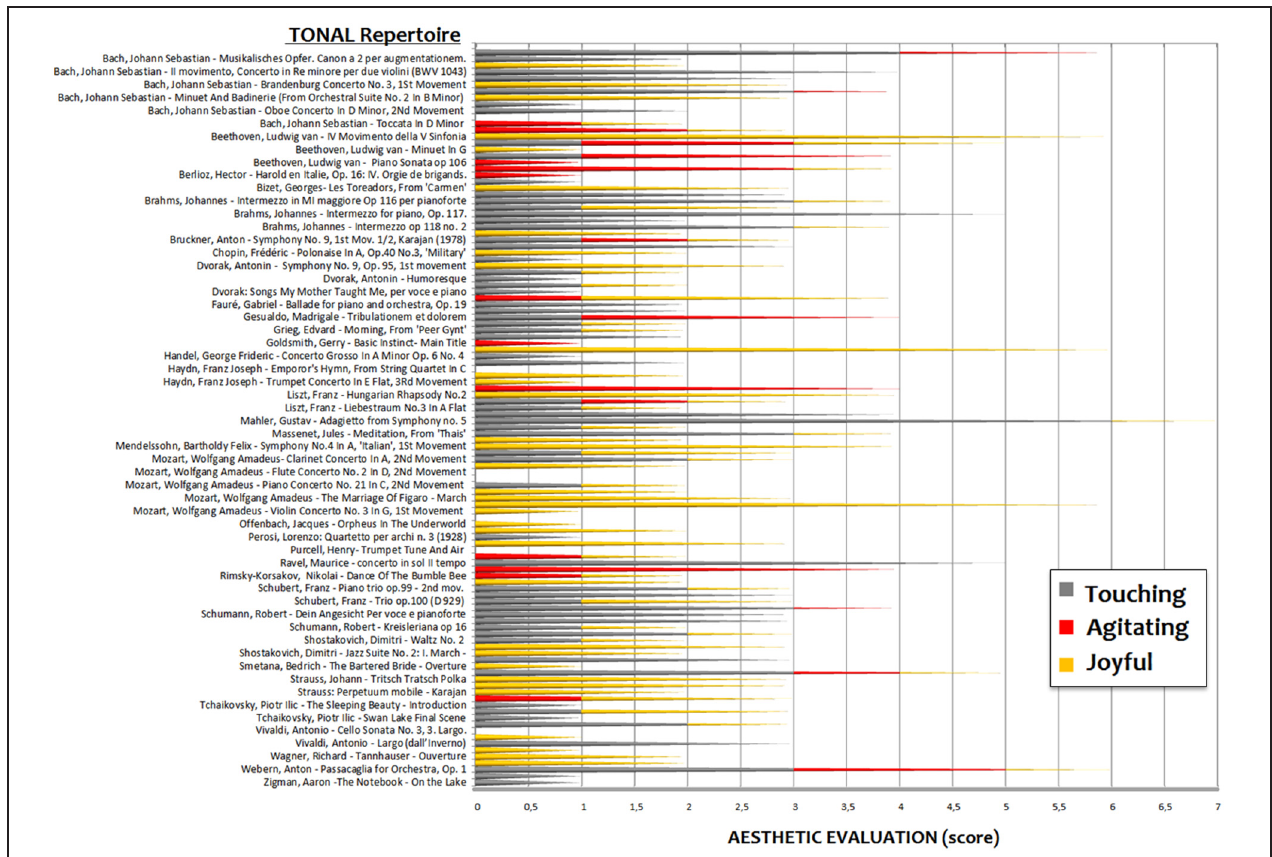
FIGURE 1 | Esthetic assessment of tonal artworks with respect to the three emotional categories (according to the evaluations of 20 conductors, composers, and conservatory professors). As in Kallinen (2005) emotional categorization showed a marked inter-individual variability. However, (unlike in the above study, in which there were only a few pieces that were mentioned more than once or twice to illustrate a given emotion), many pieces were categorized in an extremely coherent